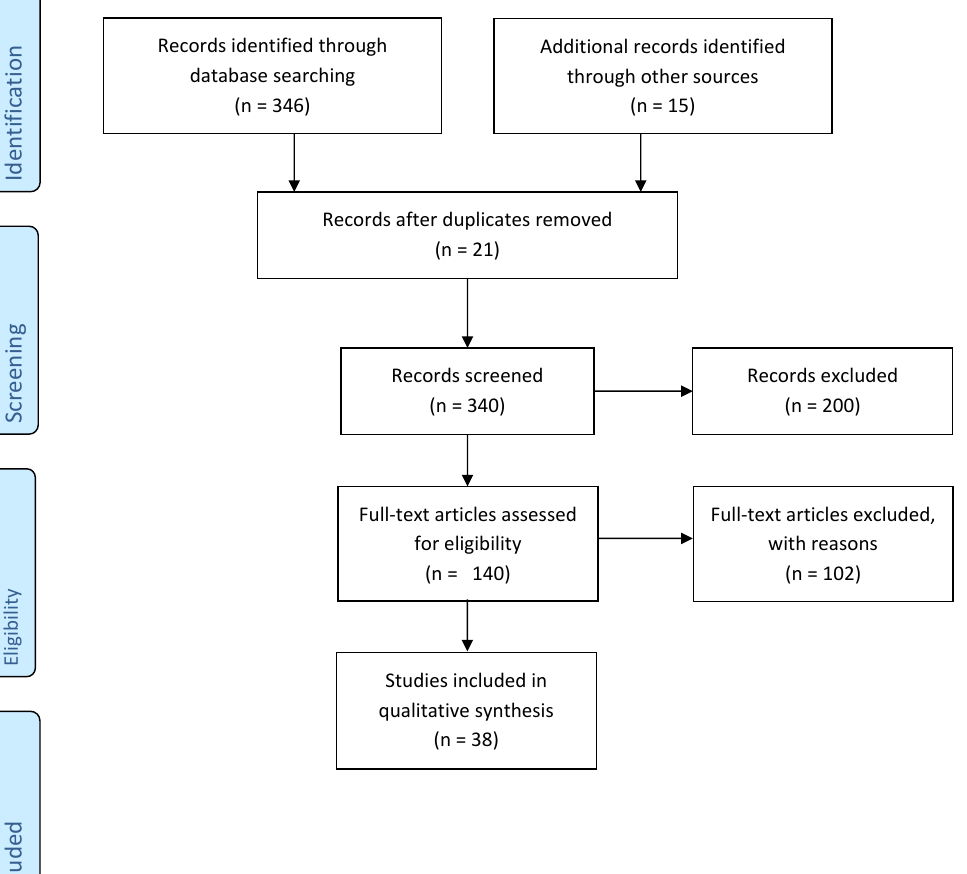
Figure1. The number of records identified, included and excluded through the different phases of the review.